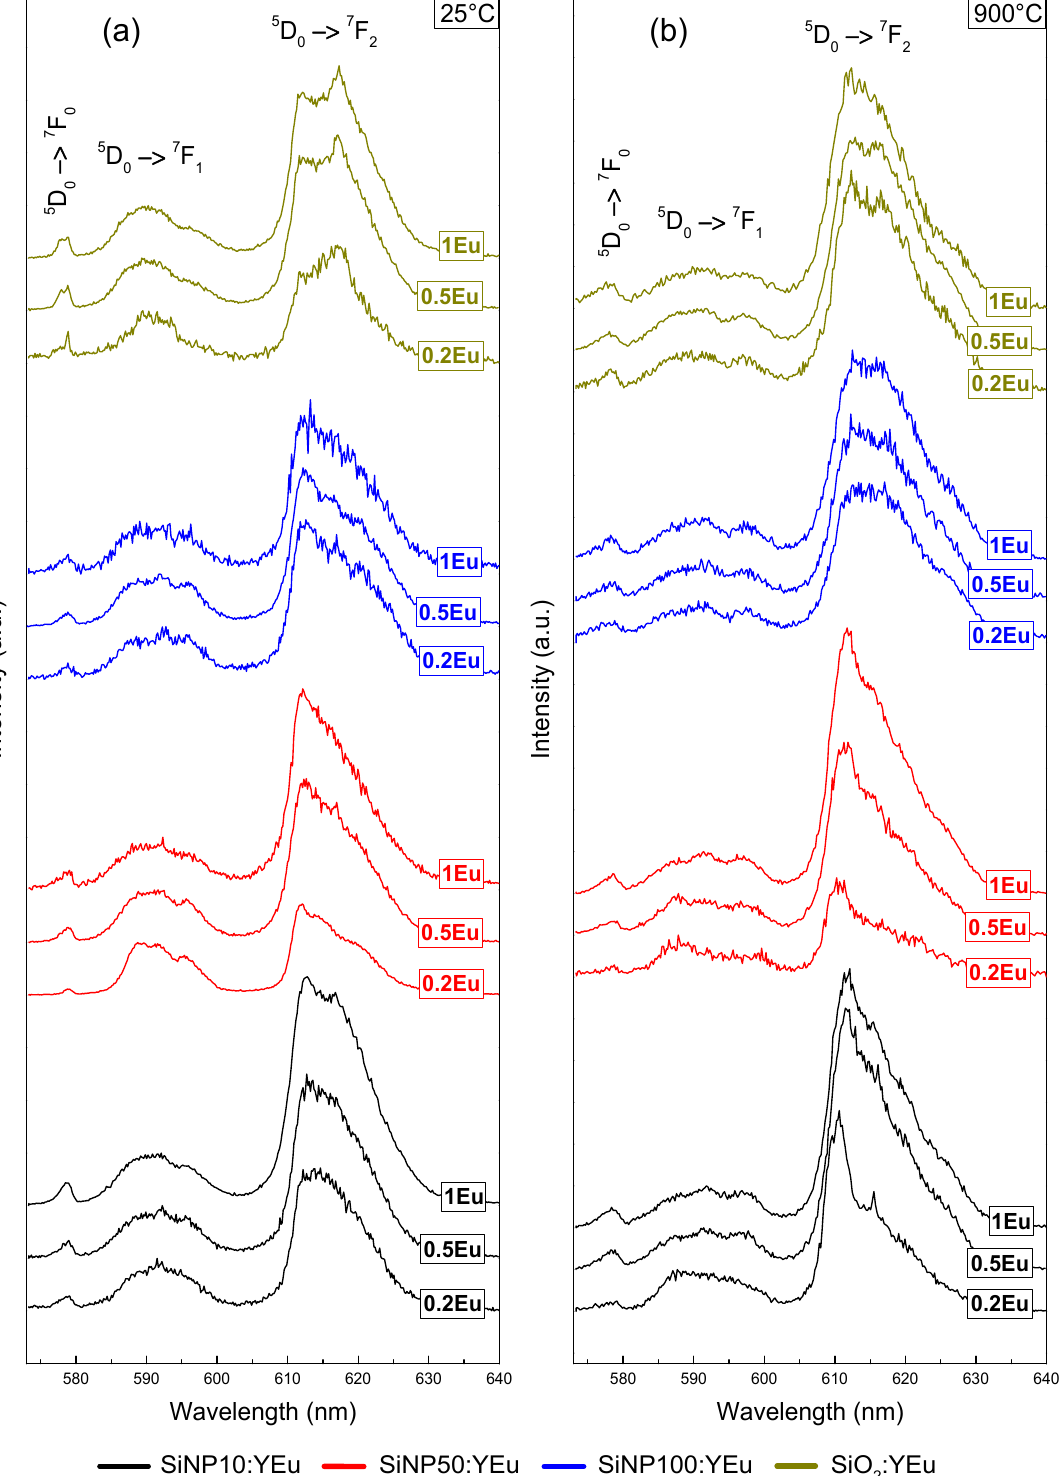
Figure 5. Emission spectra obtained under pulsed laser excitation at 532 nm at room temperature of Eu-doped silica nanoparticles and bulk ( a ) before and ( b ) after thermal treatment at 900 °C (the intensities are normalized to the maximum of the emission band 5 D 0 → 7 F 1 ).